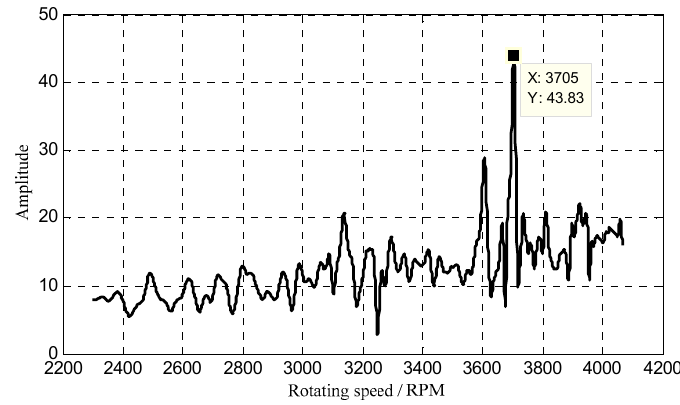
Figure 27. Order tracking spectrum of the 36th EO.